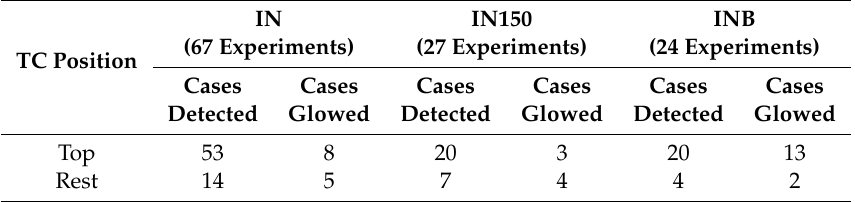
Table 8. Axial positions of CHF